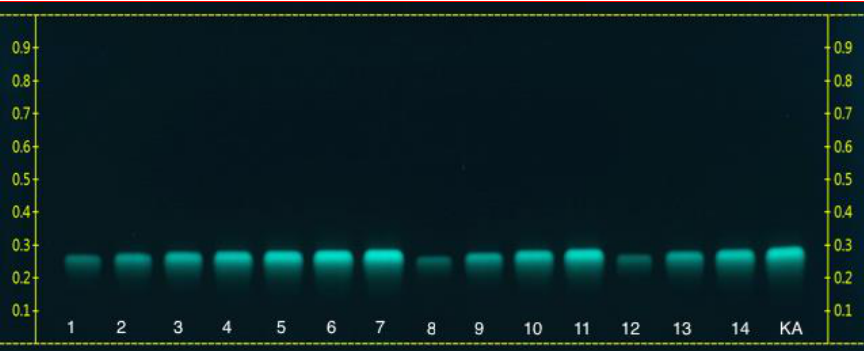
Figure 2. Photograph of thin layer chromatography (TLC) of ethyl acetate fraction at 366 nm. Kaempferol (KA); spots: 1–14 for ultrasonicated Ocimum basilicum extracts.